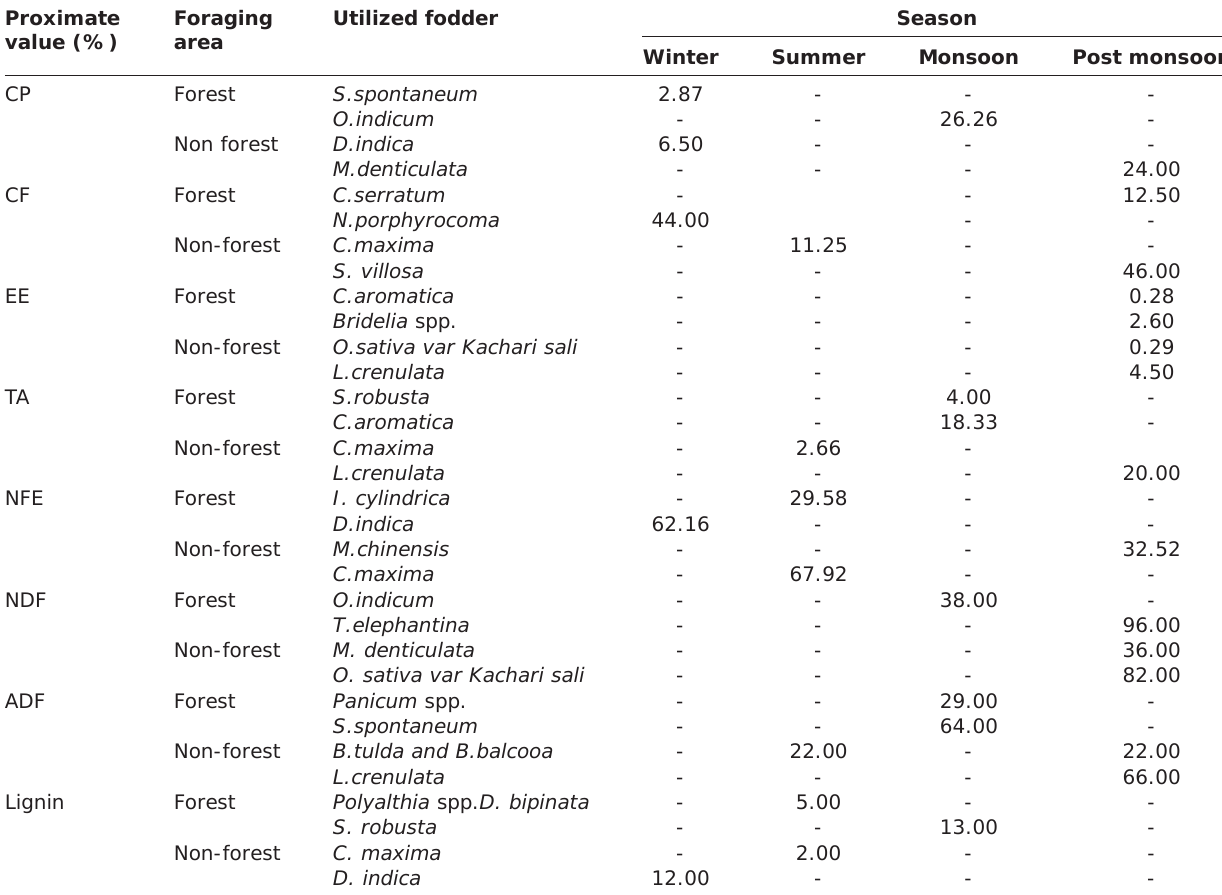
Table-6: Lower and higher proximate value (%) of consumed fodder in study area by wild Asian elephants. Proximate Foraging value (%)